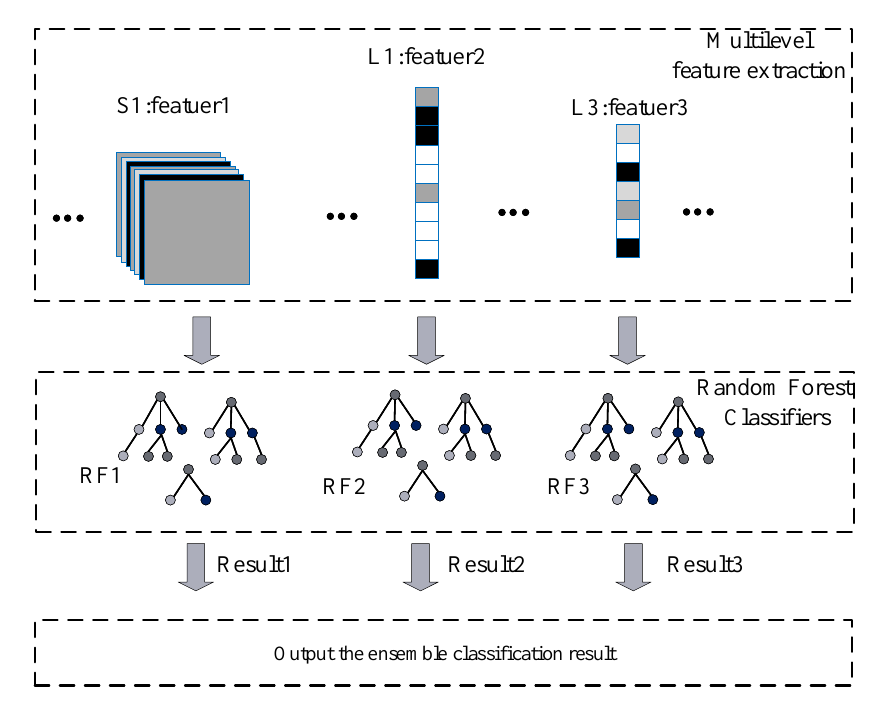
Figure 5. Ensemble classifiers.